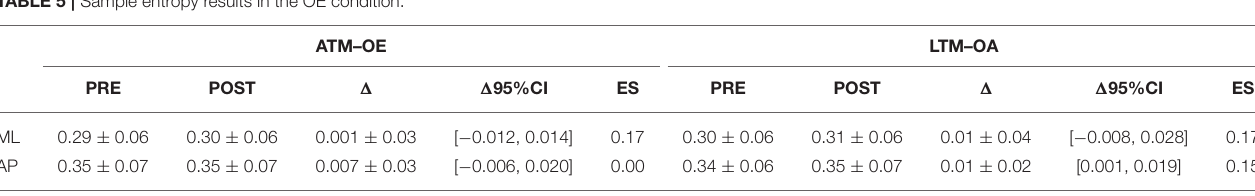
TABLE 5 | Sample entropy results in the OE condition.